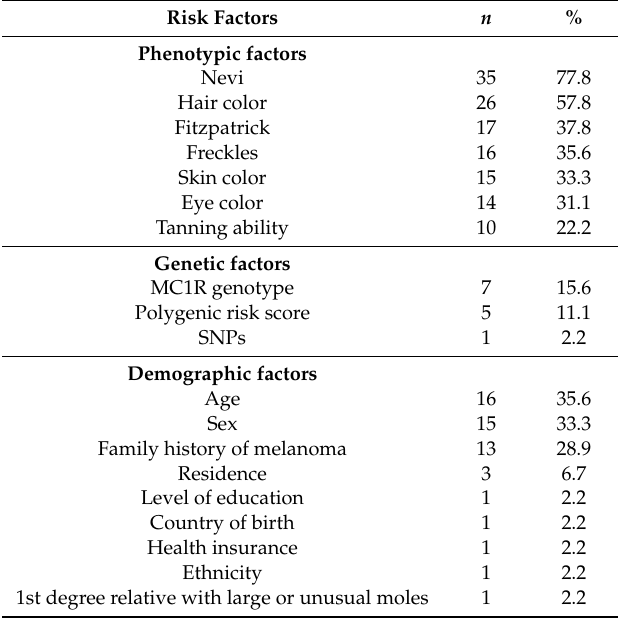
Table 1. Absolute ( n ) and relative frequencies (%) of predictive factors included in the risk prediction models for melanoma ( n = 45 models